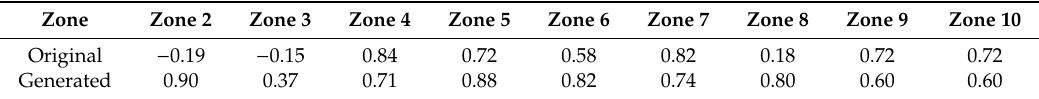
Table 10. The similarity between the generated features and the source domain, as well as the similarity between the original features and the source